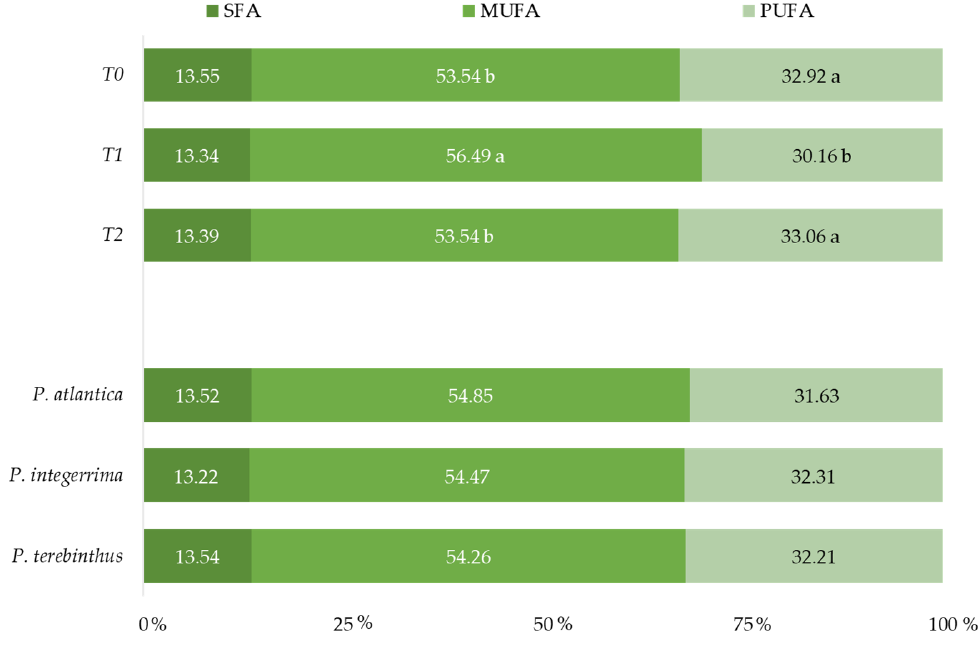
Figure 2. Fatty acid composition of pistachios as affected by deficit irrigation treatment and rootstock, grouped according to their saturation. Values (mean of 3 replications) followed by the same letter, within the same factor, were not significantly different ( p < 0.05), Tukey’s least significant difference test. SFAs = saturated fatty acids; MUFAs = monounsaturated fatty acids; PUFAs = polyunsaturated fatty acids.